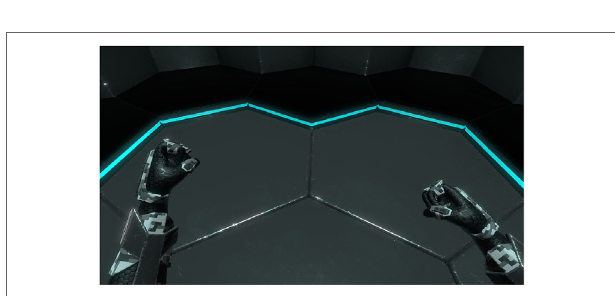
FigUre 2 | Virtual character seen from a first-person perspective (1PP) during the appropriation phase and controlled by the users thanks to the motion capture suit.